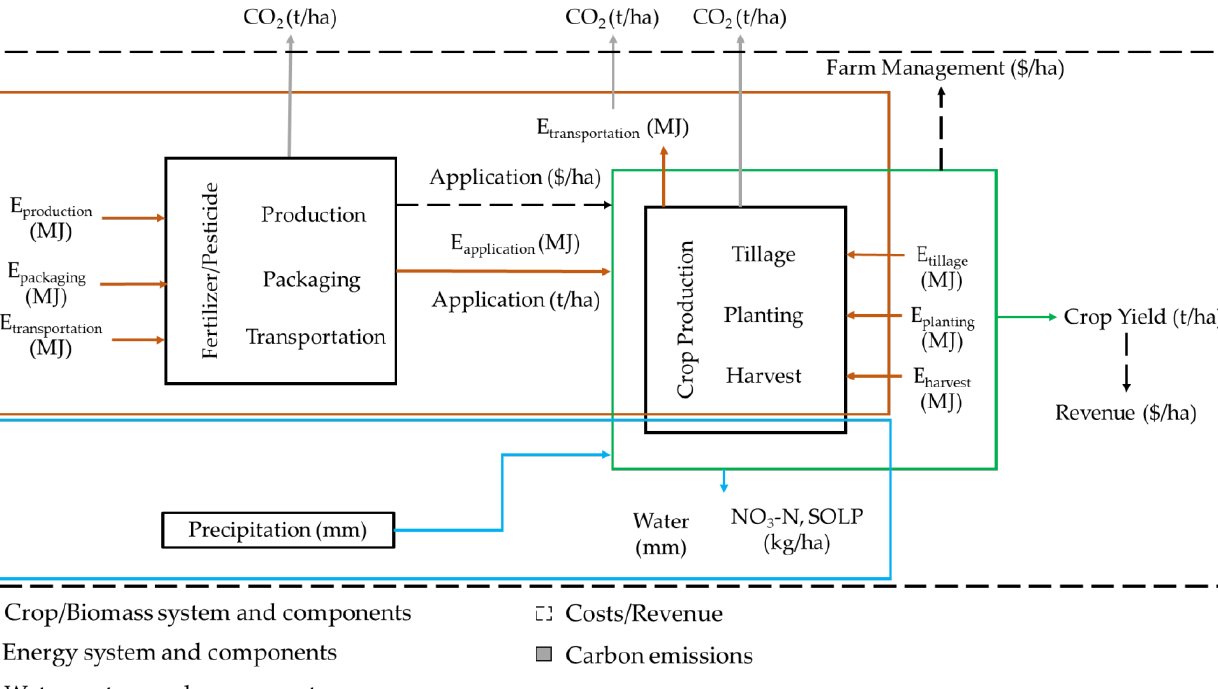
Figure 2. Schematic showing system and boundaries of the FEW nexus framework for the Matson Ditch Watershed downscaled on a hectare scale. As the Matson Ditch Watershed is precipitation-fed, the water source comes only from precipitation (mm), with the nutrients of interest in this study being surface and subsurface nitrate (NO 3 -N, kg/ha) and soluble phosphorus (SOLP, kg/ha). The energy use of each component is represented by E component (e.g., E tillage ) in MJ from fuel or electricity, with carbon emissions (CO 2 , t/ha) being an output. Food production is represented by crop yield (t/ha) along with associated revenues (USD/ha). Costs (USD/ha) include fertilizer and pesticide application, and general costs of farm management.